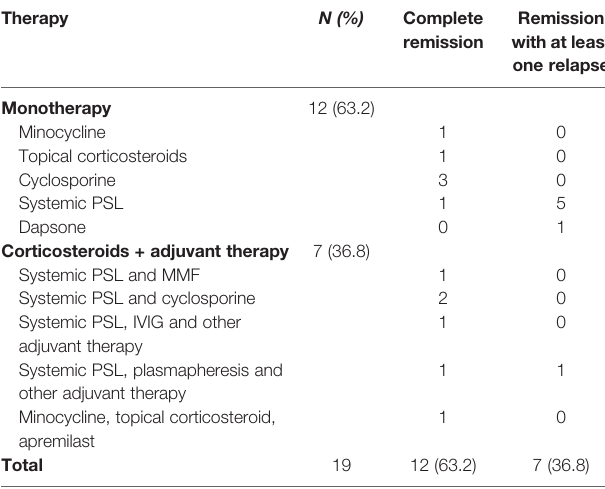
TABLE 6 | Treatment tactics of reported patients with psoriasis and anti-lam g 1